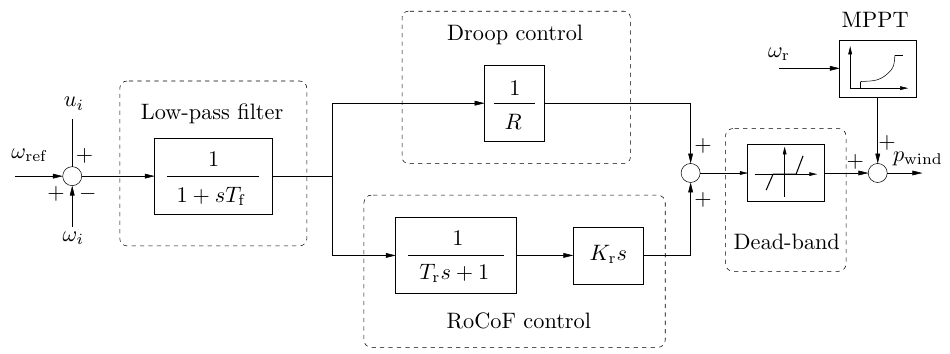
Figure 4. Frequency control of